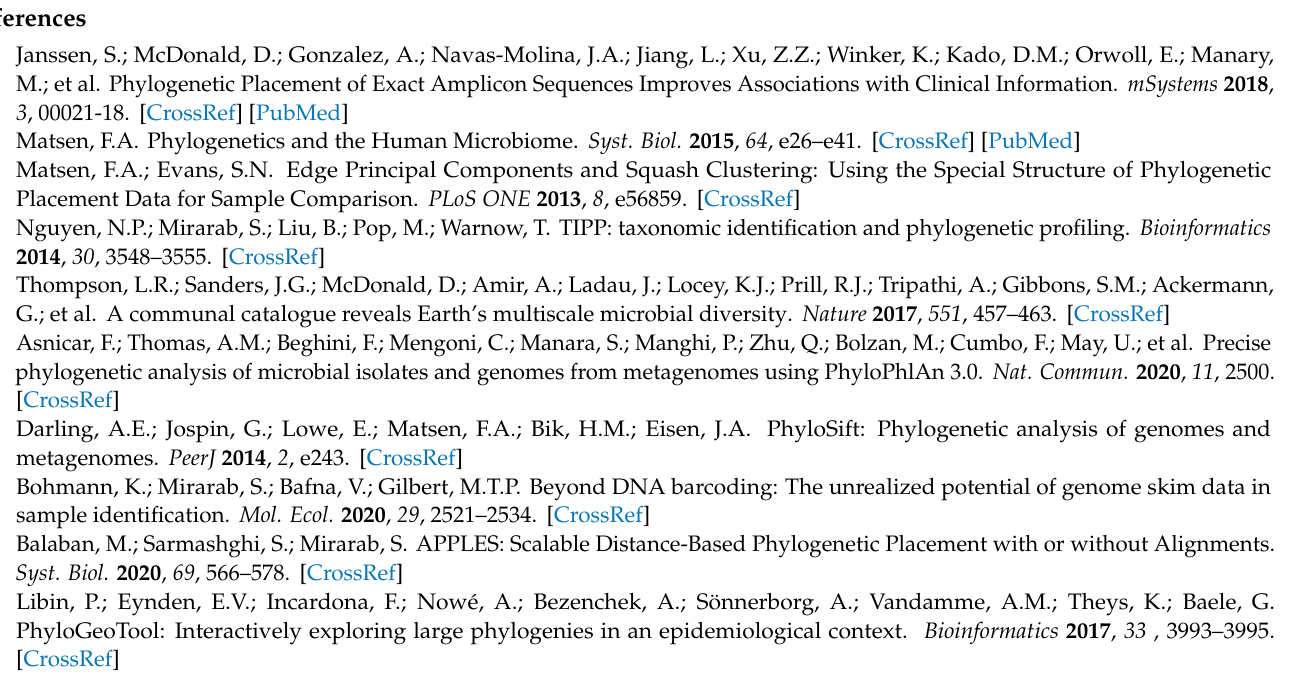
Figure A4. Results for the RNAsim single-gene and WOL multi-gene datasets. We show the correlation between the support values and the LSE on the ( A ) RNAsim, ( B ) WOL 10 genes, ( C ) WOL 25 genes, and ( D ) WOL 50 genes